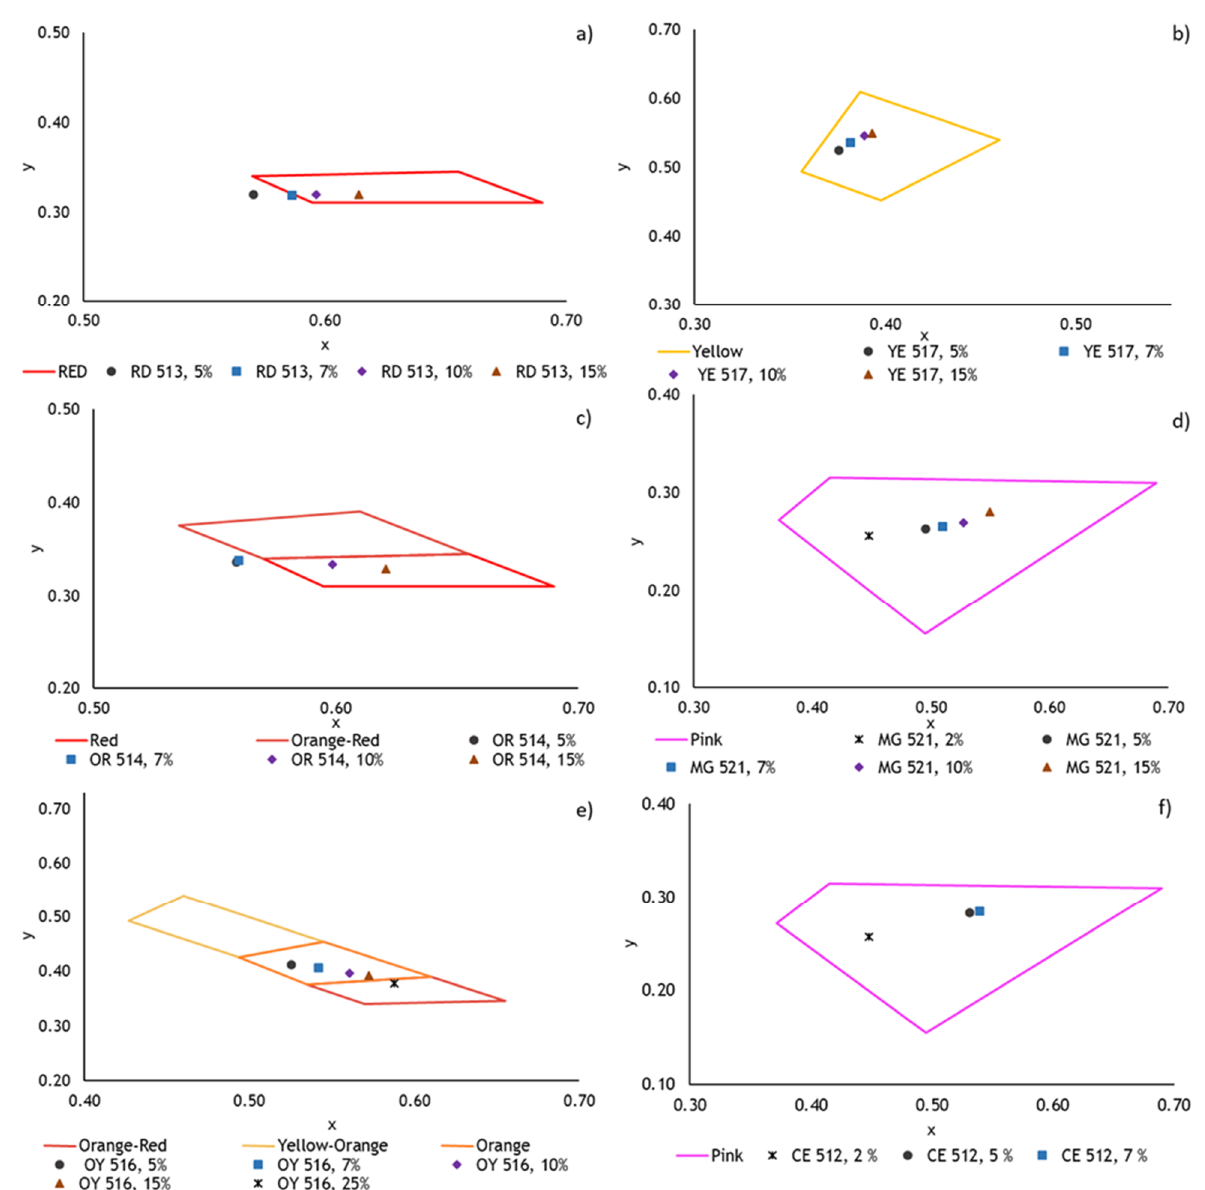
Figure 2. Chromaticity coordinates obtained for different pigments and additivation percentage: ( a ) RD 513 pigment (5, 7, 10 and 15%); ( b ) YE 517 pigment (5, 7, 10 and 15%); ( c ) OR 514 pigment (5, 7, 10 and 15%); ( d ) MG 521 pigment (2, 5, 7, 10 and 15%); ( e ) OY 516 pigment (5, 7, 10, 15 and 25%); ( f ) CE 512 pigment (2, 5 and 7%).